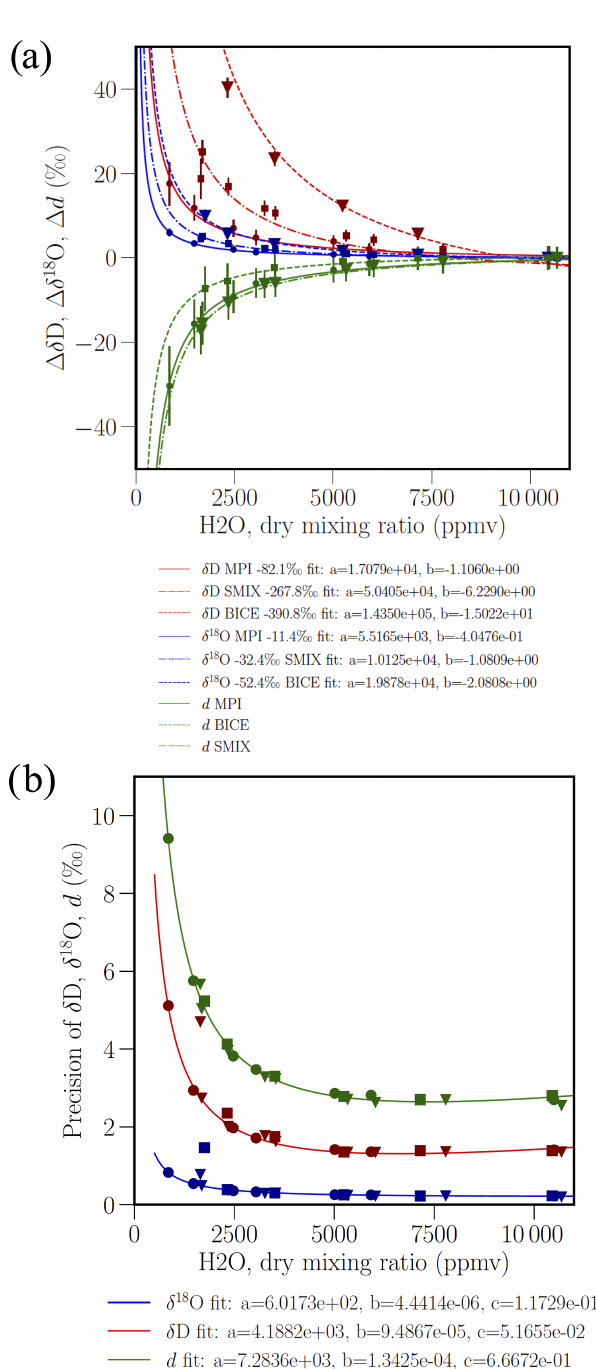
Figure 7. Bias corrections and uncertainties associated with the ATR water vapor isotopic measurements: (a) symbols illustrate the humidity dependence of the isotopic measurements for three dis- tinct liquid standards (MPI, SMIX, BICE), while lines show the cor- rection functions used to remove the detected biases in δ 18 O (blue) and δ D (red); (b) precision of the isotopic measurements as a func- tion of the measured water vapor